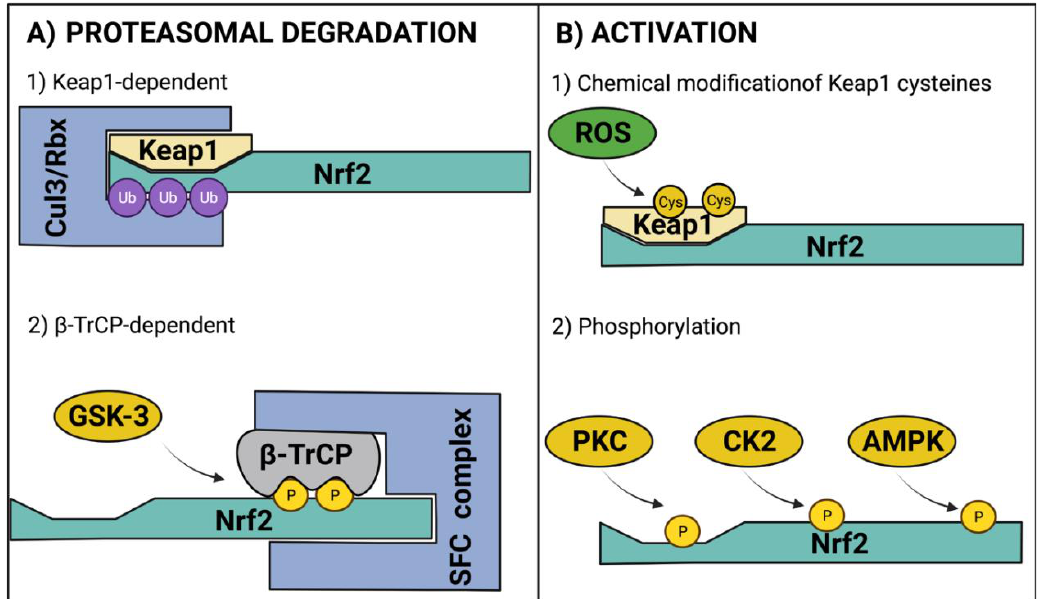
Figure 2. Regulatory mechanisms of Nrf2. ( A ) For Nrf2 regulation at protein level, Nrf2 is ubiquitinated (Ub) for its proteasomal degradation through Keap1-dependent and β -TrCP-dependent mechanisms. ( B ) For Nrf2 activation, the canonical pathway involves the chemical modification of Keap1 cysteines (Cys) that elicits the release of Nrf2 for its nuclear translocation. Additionally, phosphorylation (P) by cytosolic kinases promotes Nrf2 activation. AMPK, AMP-activated protein kinase; β -TrCP, beta-transducin repeat-containing protein; CK2, casein kinase 2; Cul3, cullin 3; GSK-3, glycogen synthase kinase 3; Keap1, kelch-like ECH-associated protein 1; Nrf2, nuclear factor erythroid 2-related factor 2; PKC, protein kinase C; Rbx, ring box-1; ROS, reactive oxygen species; SFC, Skp1 – Cullin – F-box protein complex. Figure created with BioRender at biorender.com (accessed on 10 February 2022) .